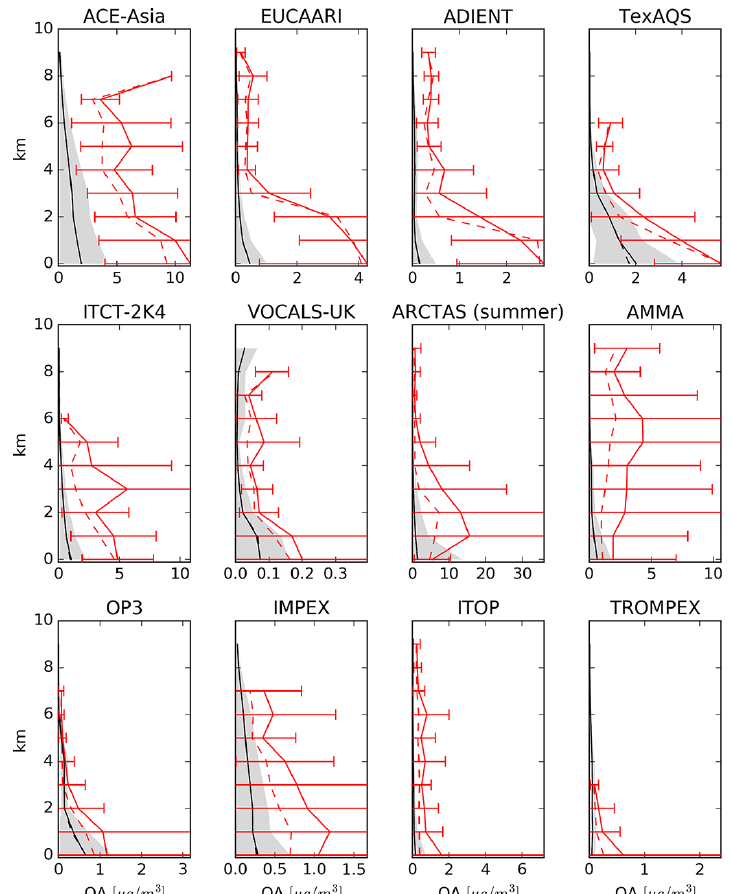
Figure 31. The same as Fig. 22 but for organic